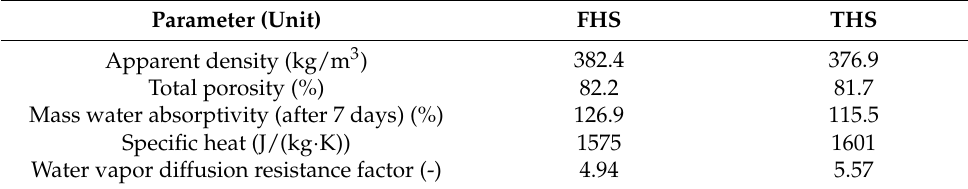
Table 5. The basic physical properties of the tested composites